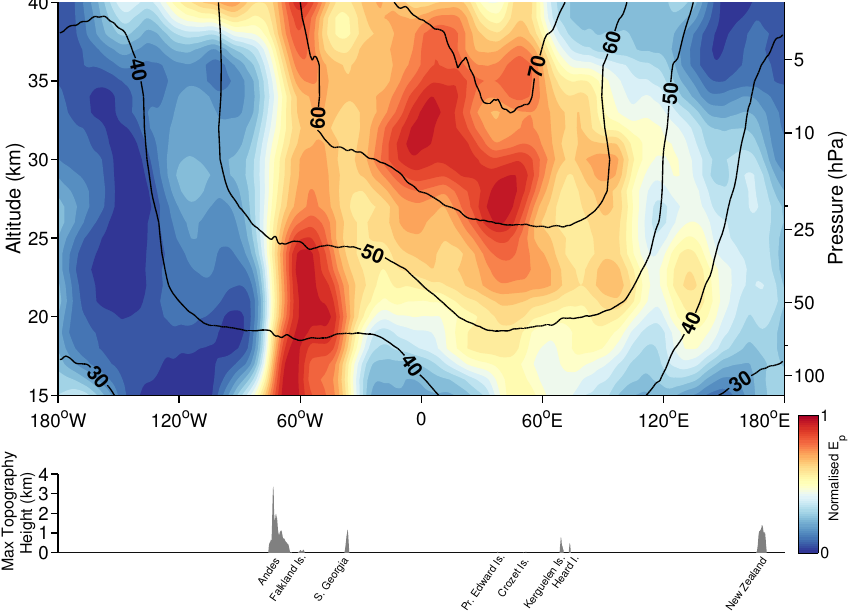
Figure 4. Normalised monthly-mean zonal cross section of E p for August 2010 over Southern Ocean (top panel) and maximum topography height (bottom panel) in a ± 10 ◦ slice centred on 50 ◦ S. Monthly-mean zonal-mean winds from ECMWF operational analyses are shown by thick contours in the top panel, at intervals of 10ms − 1 . Note the E p has been normalised at each height level to highlight the vertical